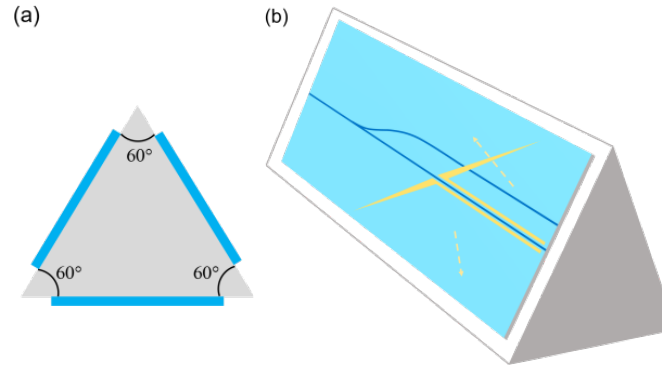
Figure 2. ( a ) Lateral view and ( b ) perspective view of the packaged 3D sensor. The polarization simulation model of the inclined tapered dipole antennas is shown in Figure 3a, where ϕ is the degree versus to z-axis and is set to be 90 ◦ . θ 1 and θ 2 are the degrees of the two tapered antennas versus to x-axis. The simulation result using the High-Frequency Structure Simulator (HFSS) software is shown in Figure 3b. The axial ratio at the line of the antennas is over 37.5 dB, which indicates that the inclined tapered dipole antennas have an absolute linear polarization.